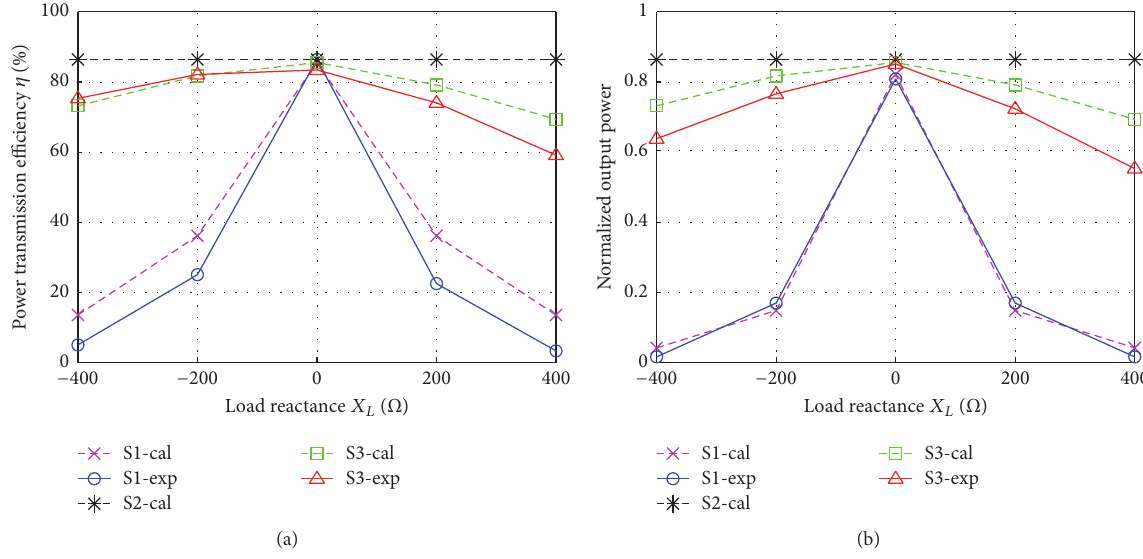
Figure 10: Comparison of three kinds of WPT systems. S1: the original WPT system; S2: the dual-side impedance-matching WPT system; S3: the frequency-tracking and impedance-matching combined WPT system. (a) Power transmission efficiency versus load reactance. (b) Output power versus load reactance.